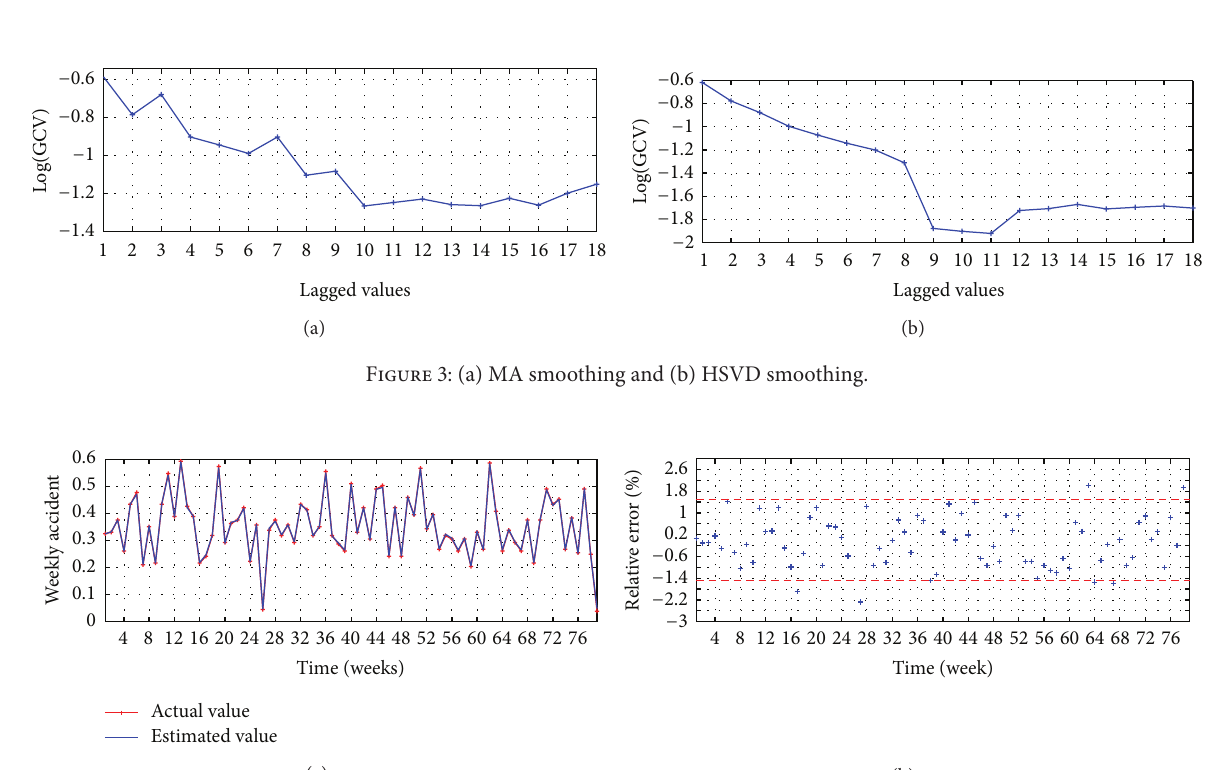
Figure 2: Accidents time series: (a) raw data and (b) autocorrelation function.